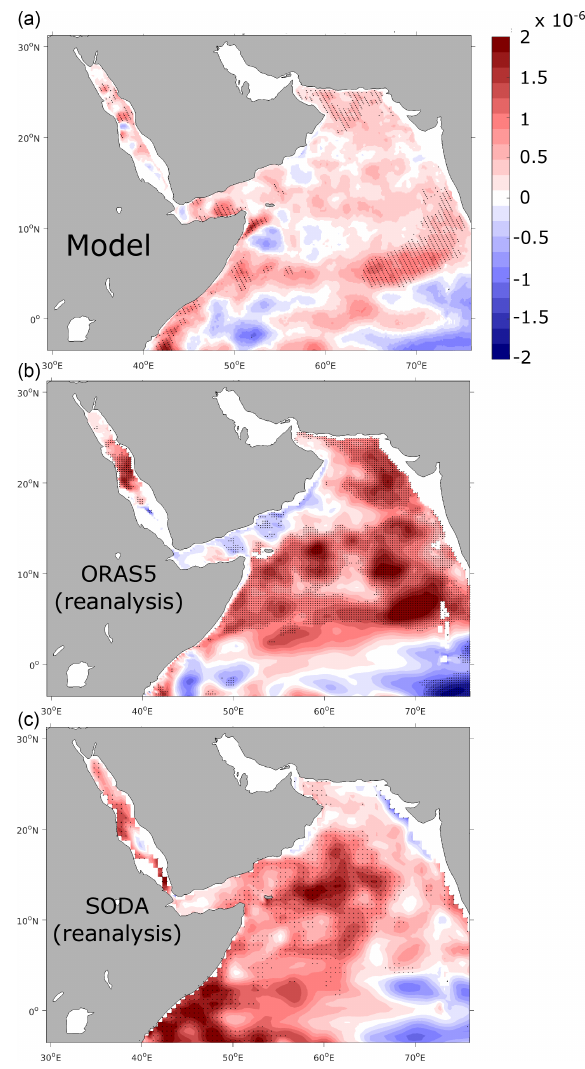
Figure 3. Trends in upper-ocean vertical stratification. Linear trends ∂σ in static stability E = − 1 (with σ the density of the water and z σ ∂z the depth) at 100m (in m − 1 per decade) between 1982 and 2010 as simulated in ROMS (a) and from ORAS5 (b) and SODA (c) reanal- yses. Statistically significant trends at the 95% confidence interval following a Mann–Kendall (MK) test are represented by